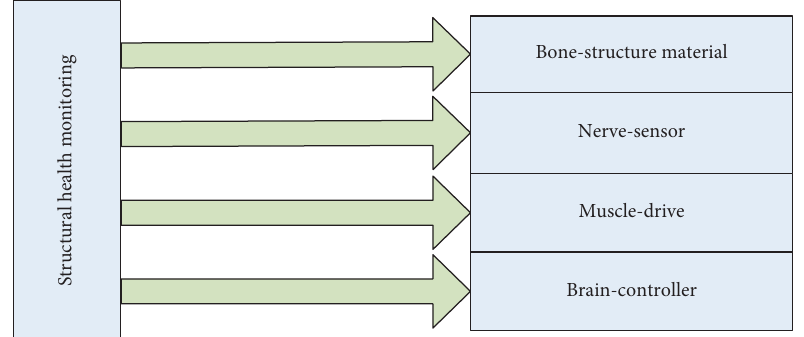
Figure 1: Health monitoring